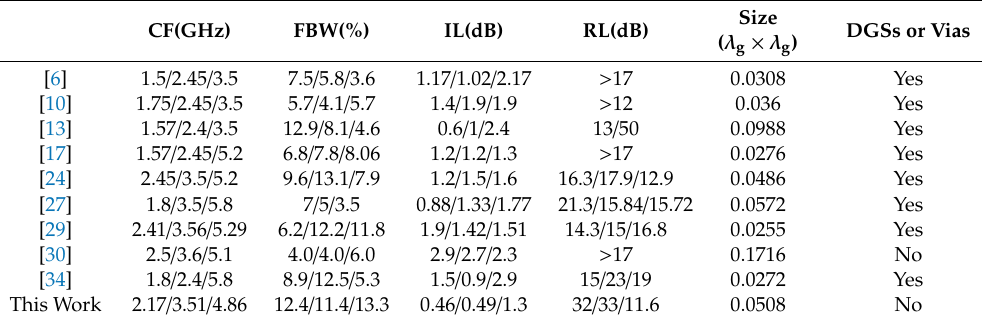
Table 2. Performance comparison with other tri-band